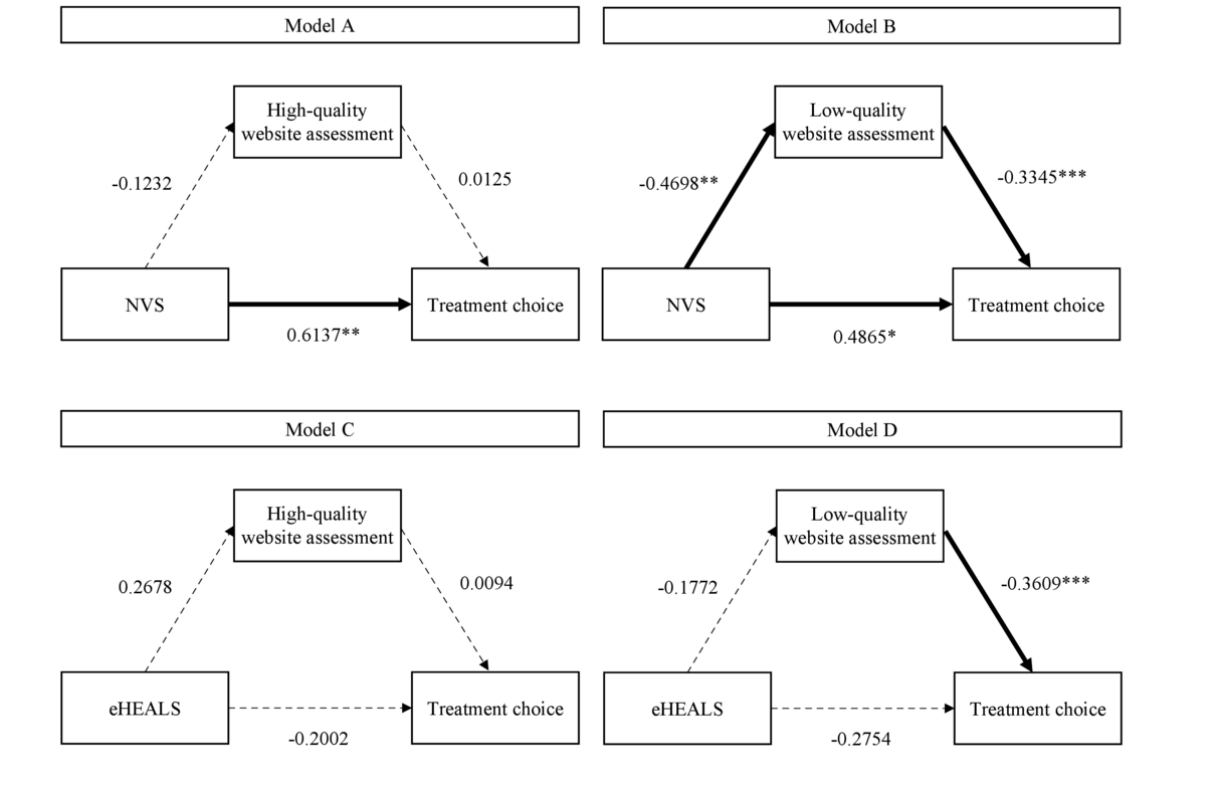
Figure 1. Mediation analyses. eHEALS: eHealth Literacy Scale; NVS: Newest Vital Sign. * P <.05; ** P <.01; *** P